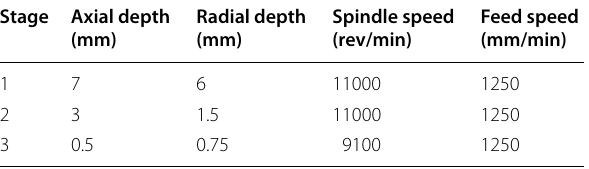
Table 2 Optimized cutting parameters in whole cutting process Stage Axial depth